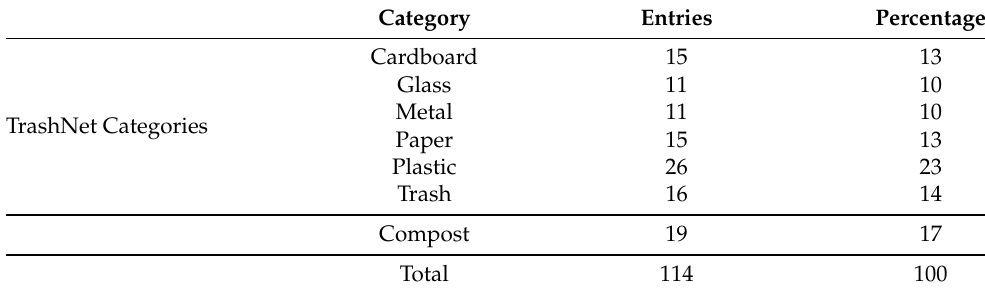
Figure 2. Littered waste testset: two samples for each class. Table 2. Distribution of the Categories on the Littered waste